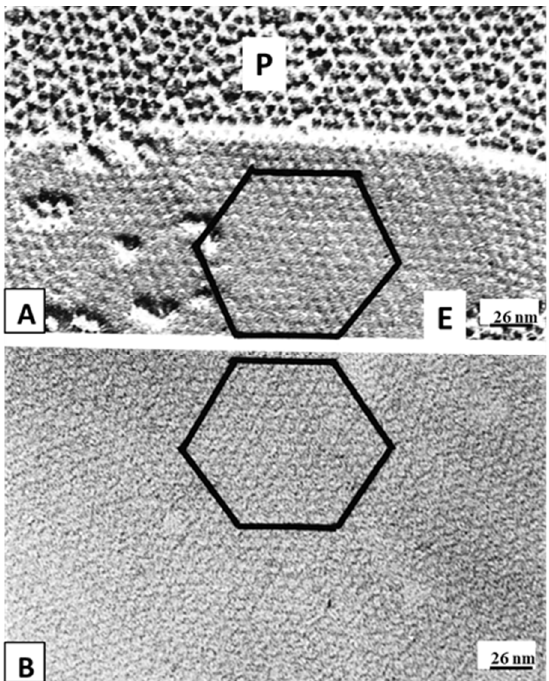
Figure 16. Gap junctions of rat liver epithelium (in uncoupled state) from a freeze-fracture replica ( A ) and an isolated, negatively stained junction ( B ). Isolated junctions ( B ) display crystalline (hexagonal) arrays identical to those of uncoupled junctions ( A ). The channels of both gap junctions are believed to be in irreversibly closed state (Ca-CaM locked state). In both junctions, the channels are hexagonally packed at an average center-to-center spacing of −8.5 nm. Adapted from ref. [129].